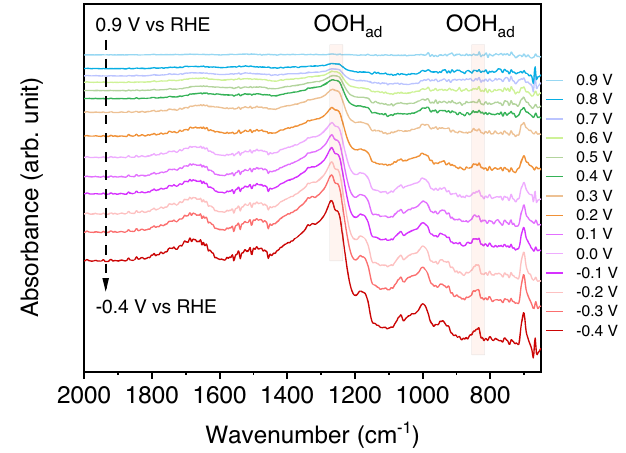
Fig.4 |Insitudetectionof*OOHspecies. InsituATR-SEIRASspectracollected on CoPc-OCNT catalyst in O 2 -saturated 1.0 M KOH catholyte at different potentials from 0.9 to − 0.4V vs RHE (OOH ad : adsorbed